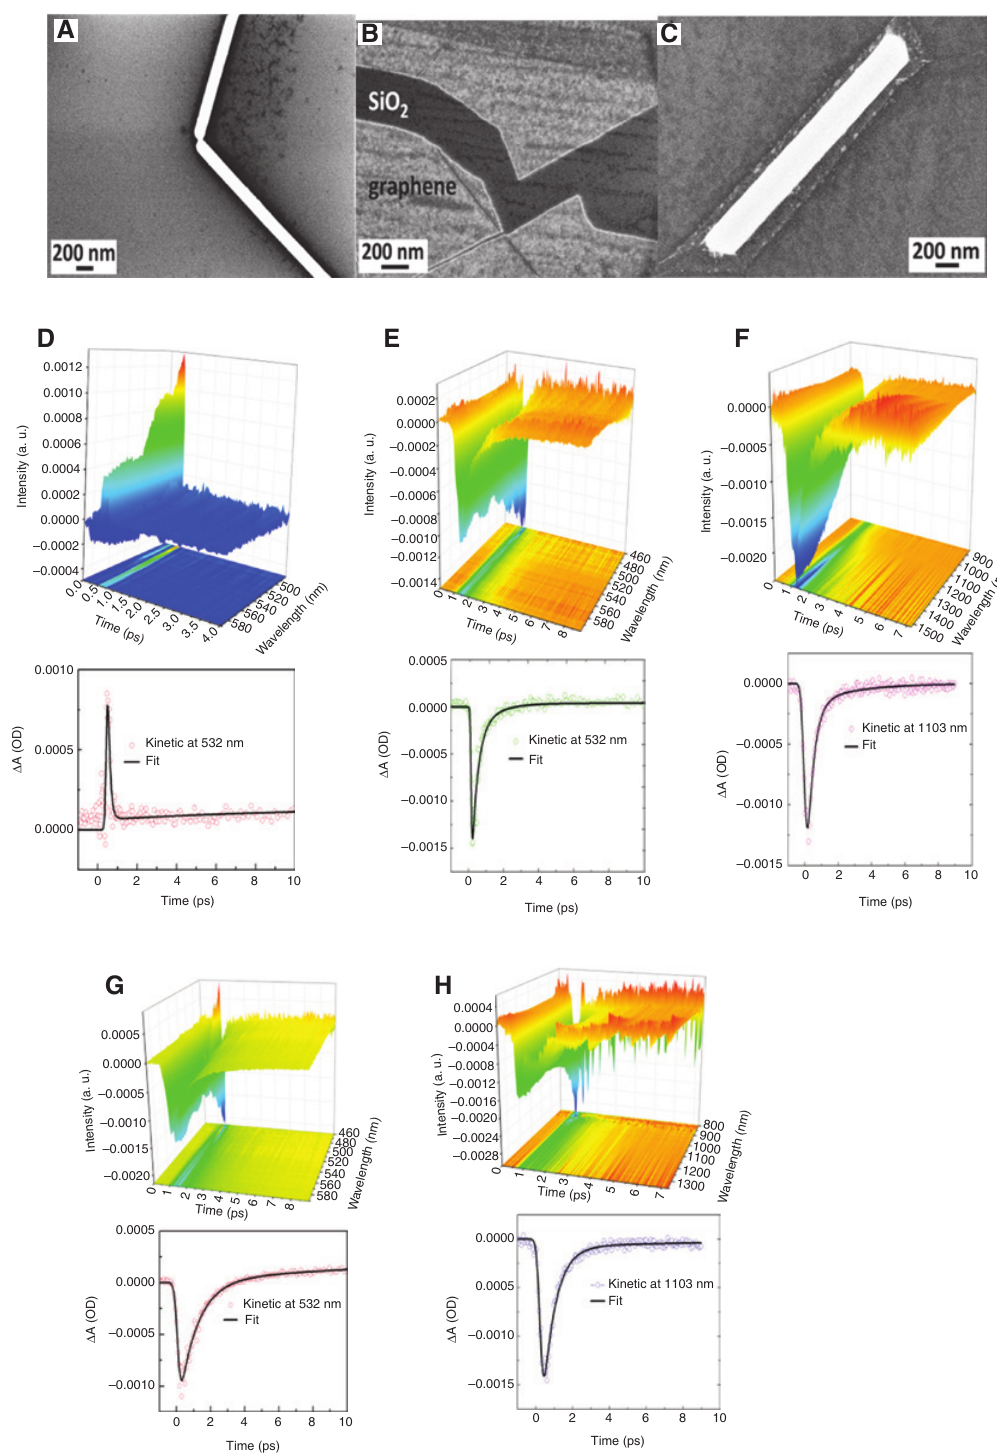
Figure 8: SEM image of silver nanowires, single-layer graphene, a single nanowire veiled with monolayer graphene, and UPPTRA